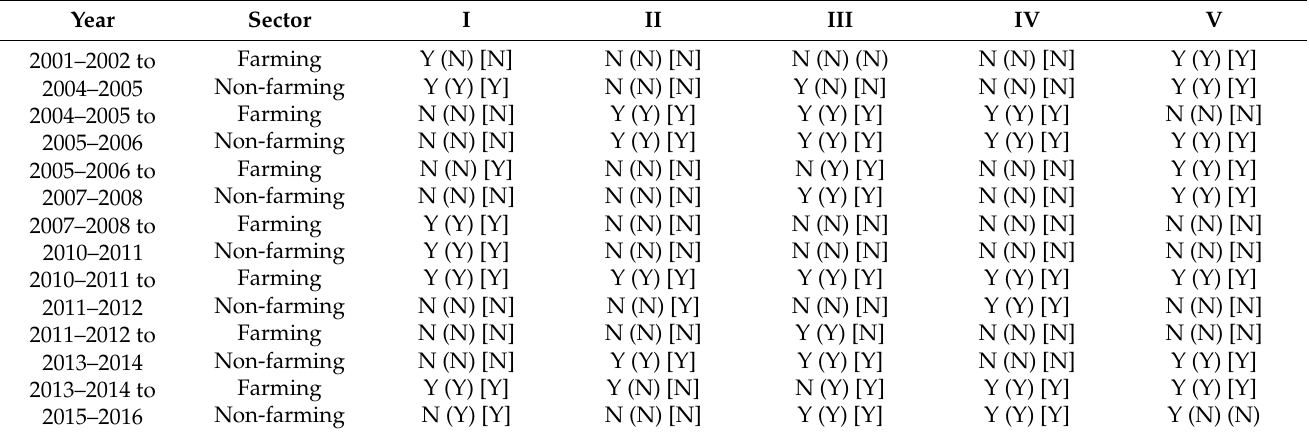
Table 4. Relative PEGR for farming and non-farming communities across agro-climatic